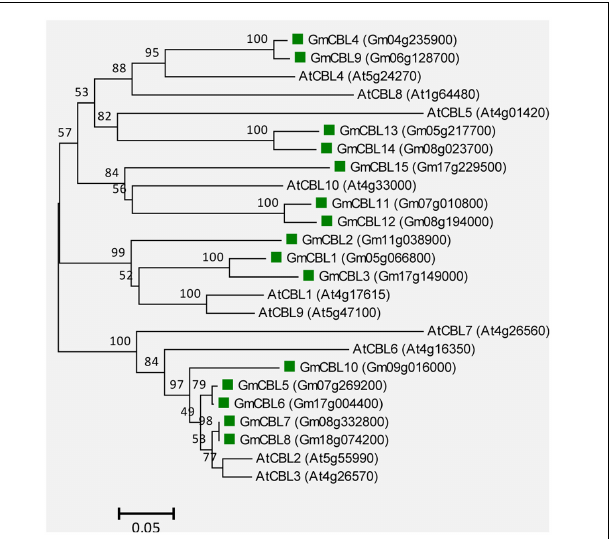
FIGURE 6 | Unrooted phylogenetic tree of the total CBL proteins from soybean ( G. max ) and A. thaliana . The alignment for the phylogenetic tree was performed with ClustalW using full-length amino acid sequences. The phylogenetic tree was created with the MEGA6 software and the neighbor-joining method with 1,000 bootstrap replications. The 15 CBLs from soybean are marked with green squares, while the 10 CBLs from Arabidopsis are not marked. Locus name of each gene is shown in brackets. The bar indicates the relative divergence of the sequences examined and bootstrap values are displayed next to the